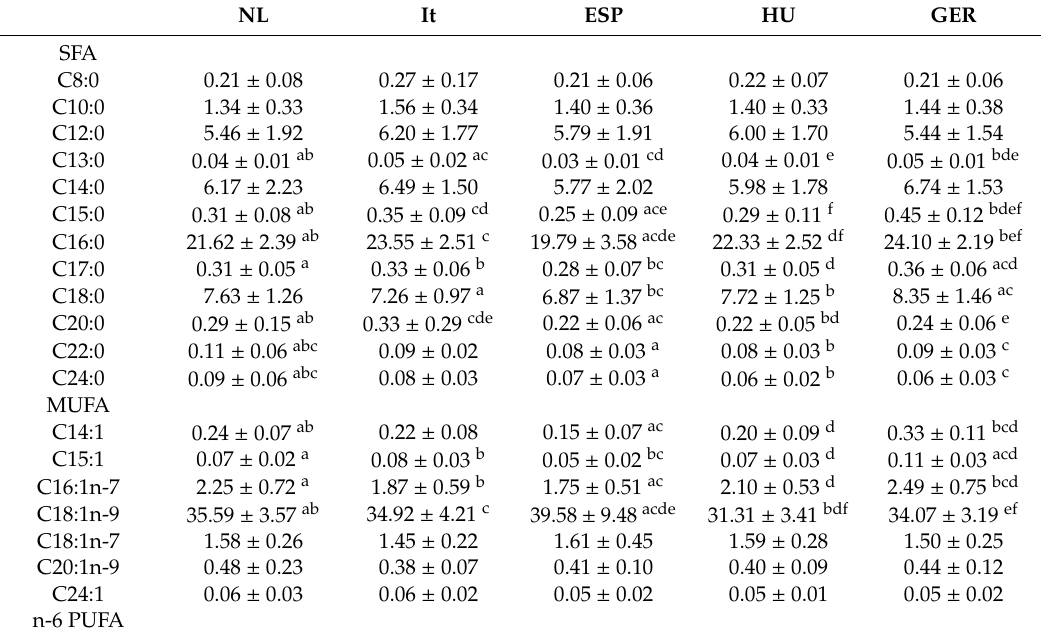
Table 6. Pearson correlations between the concentrations of macronutrients, hormones, and FA groups (weight%) stratified according to sample collection period.